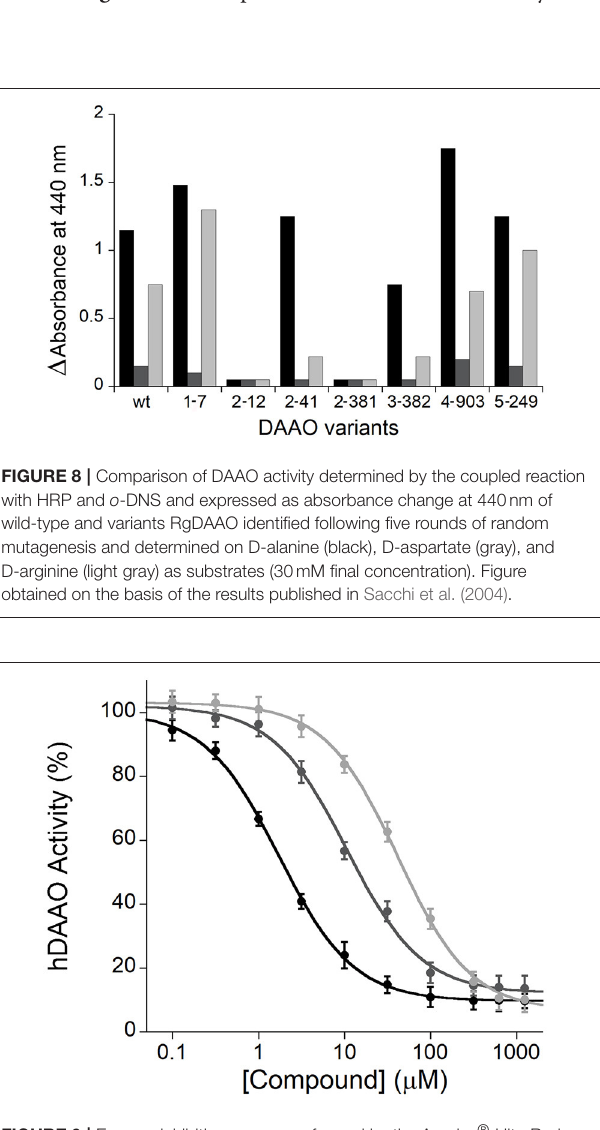
FIGURE 9 | Enzyme inhibition assays performed by the Amplex ® UltraRed method using recombinant hDAAO, D-serine as substrate and three different compounds (1, black; 2, gray; and 3, light gray) as potential inhibitors. The plot displays the mean values ± SD, n =